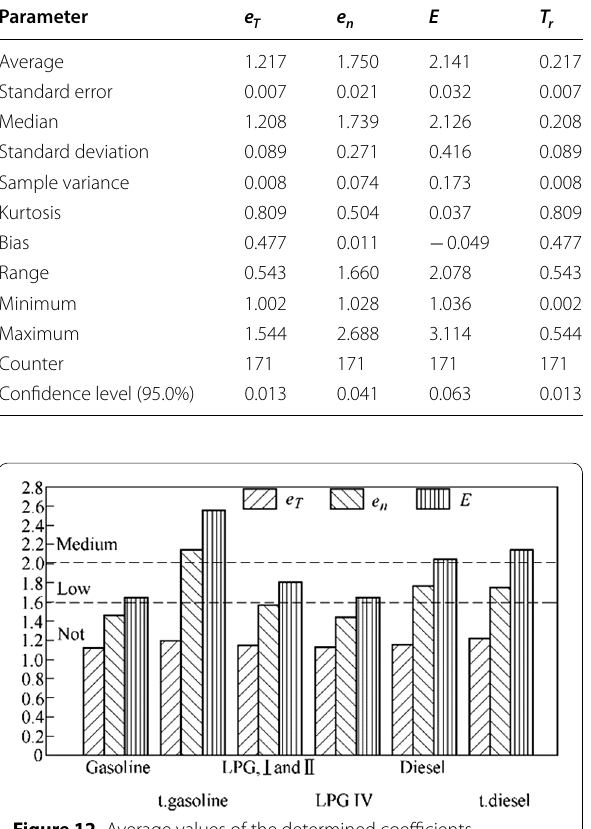
Figure 12 Average values of the determined